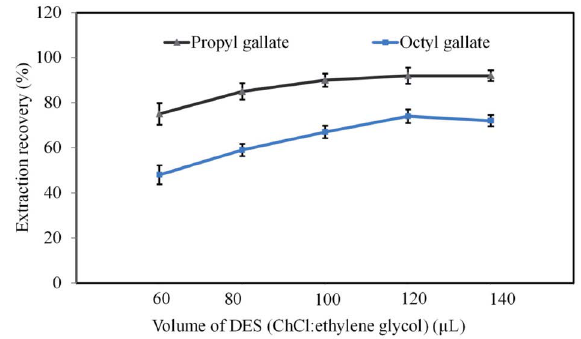
Figure 5. Effect of the volume of DES. DES, ChCl:ethylene glycol; diluent solvent, n -hexane; diluent solvent volume, 1 mL; vortex time, 5 min.